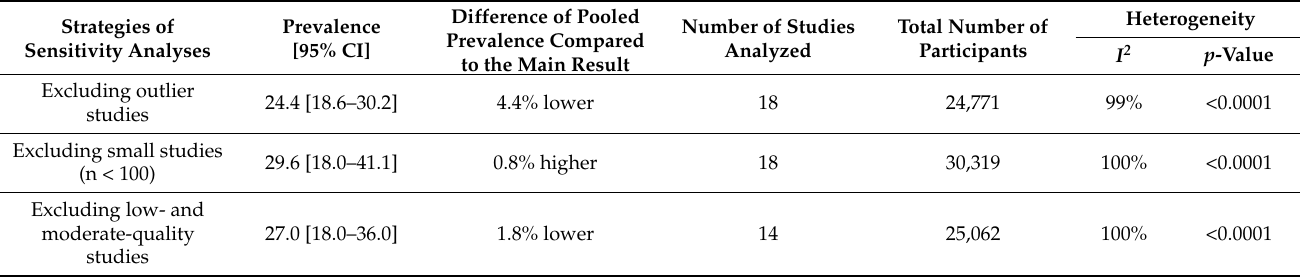
Table 3. Sensitivity